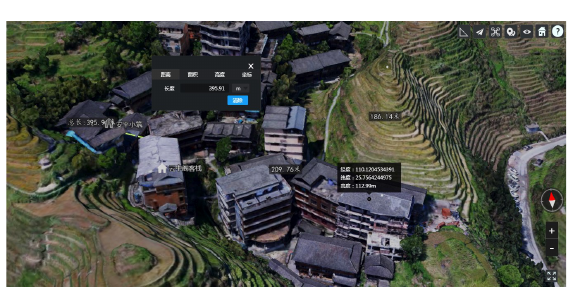
Figure 5. Spatial measurement